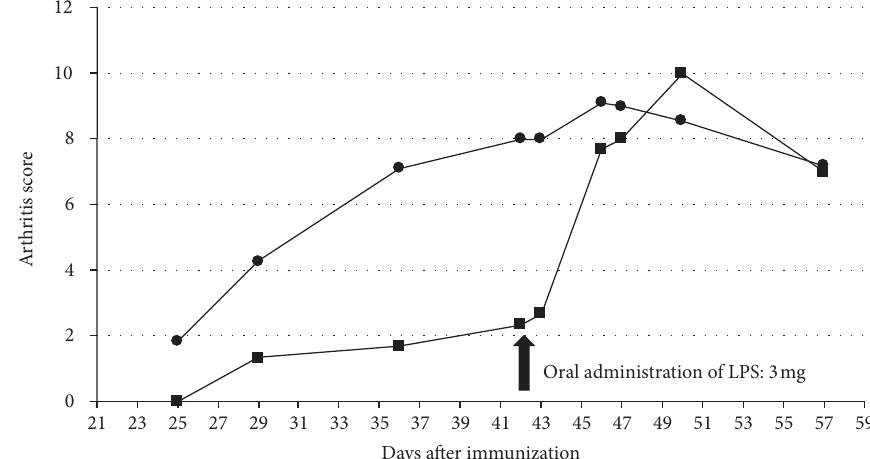
Figure 6: Exacerbating arthritis by oral administration of LPS in nonarthritic CIA mice. Mice were immunized with an emulsion of type II collagen and 1 mg/ml CFA. Nonarthritic mice failed to develop significant arthritis; however, the oral administration of LPS on day 42 induced severe arthritis in the nonarthritic mice (square), similar to the arthritic mice